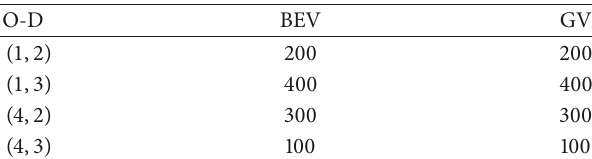
Table 1: O-D demand of Nguyen-Dupuis network.